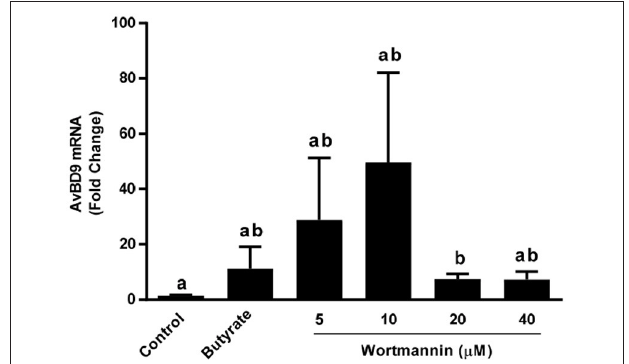
FIGURE 6 | In vivo induction of AvBD9 mRNA expression in the duodenum of chickens by wortmannin. Different concentrations of wortmannin or 40mM sodium butyrate were administered to 3-day-old chickens ( n = 12) by oral gavage every 12h for 36h. A segment of the mid-duodenum was collected and subjected to total RNA isolation and RT-qPCR analysis of AvBD9 mRNA expression. Fold changes were calculated relative to the control chickens receiving an equal volume of saline three times. The bars without common superscript letters denote statistical significance (by unpaired Student’s t